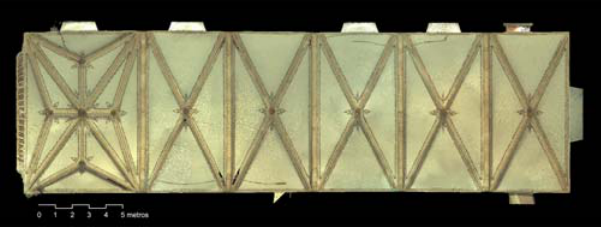
Figure 1: Zenith view of the